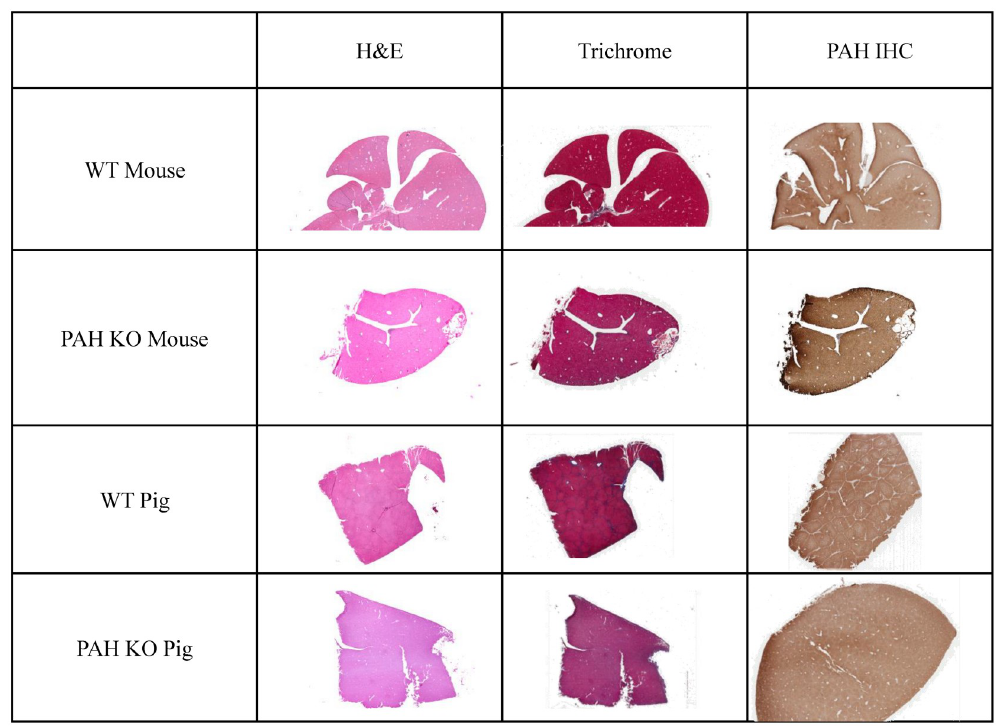
Fig 4. Histology of WT and Pah KO livers in mouse and pig. Standard H&E and Masson’s trichrome sections show no appreciable difference between WT and Pah enu2/enu2 mice or WT and PAH R408W/R408W pigs. Similarly, immunohistochemistry showed similar levels and ubiquitous distribution of expression of the wild type and mutant protein in both